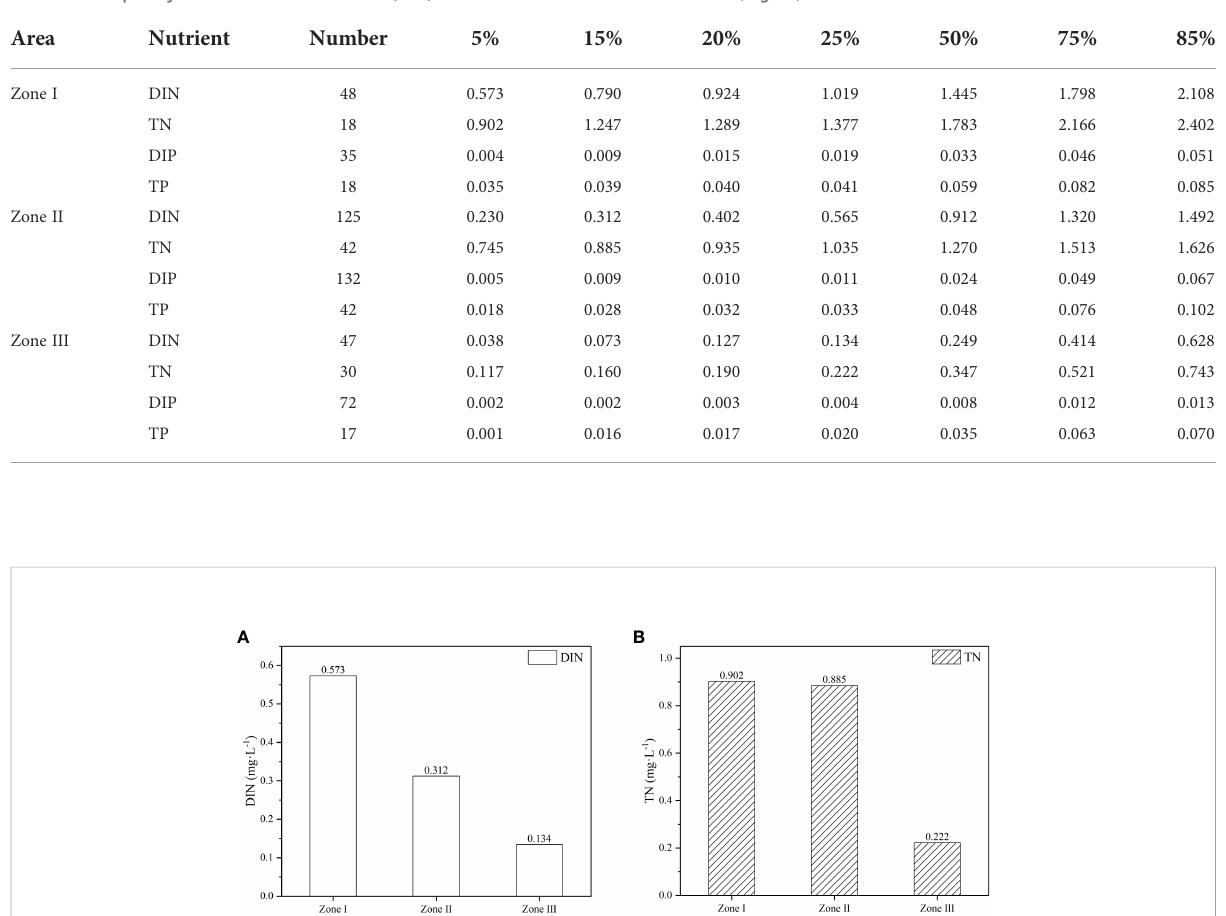
TABLE 1 Frequency distribution results of DIN, TN, DIP and TP in the PRE coastal water (mg·L -1 ).